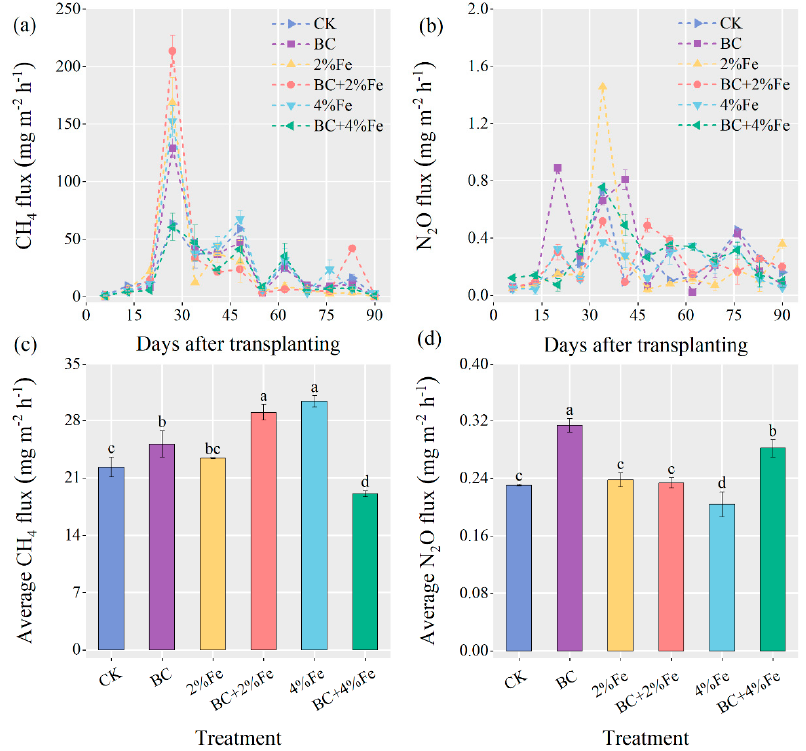
Figure 2. Emission fluxes of CH 4 and N 2 O under different treatments. ( a ) Trends in CH 4 emission fluxes, ( b ) Trends in N 2 O emission fluxes, ( c ) Average CH 4 emission flux, ( d ) Average N 2 O emission flux. The data are presented as mean (±standard error). Different lowercase letters indicate significant differences between different treatments at p < 0.05.